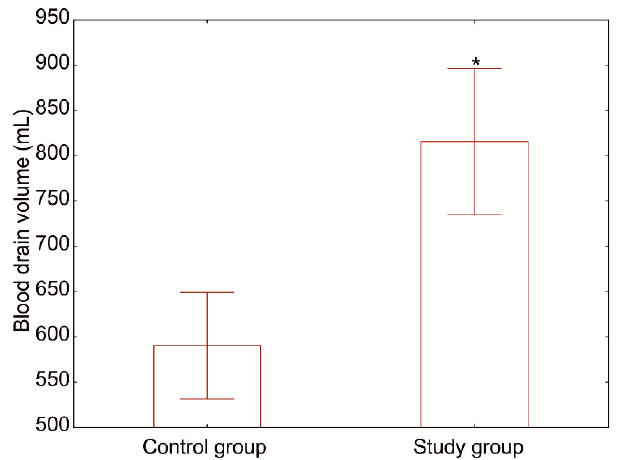
Figure 3. Blood loss during the postoperative period in the study and control groups ( p = 0.0299).